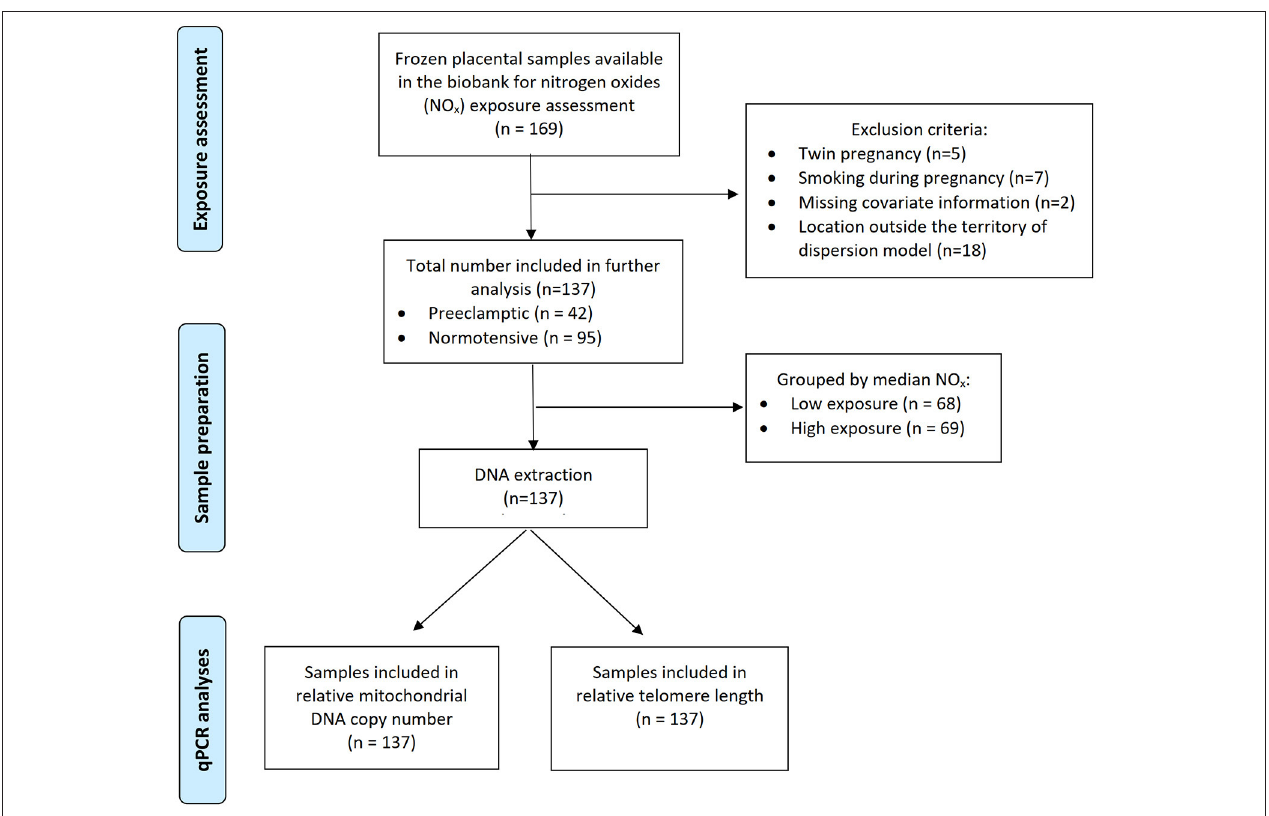
FIGURE 2 | Flowchart of the